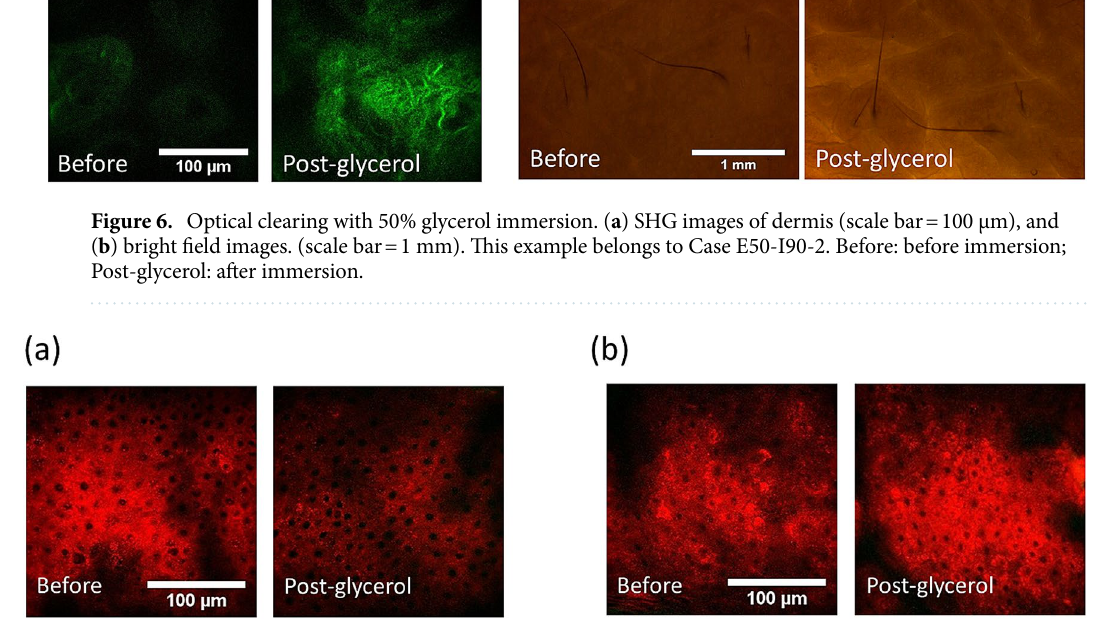
Figure 7. THG intensity variation at the middle epidermis layer of ( a ) Case E100-I90-1 with 100% glycerol and ( b ) Case E50-I90-2 with 50% glycerol. Before: before immersion; Post-glycerol: after immersion. Scale bar = 100